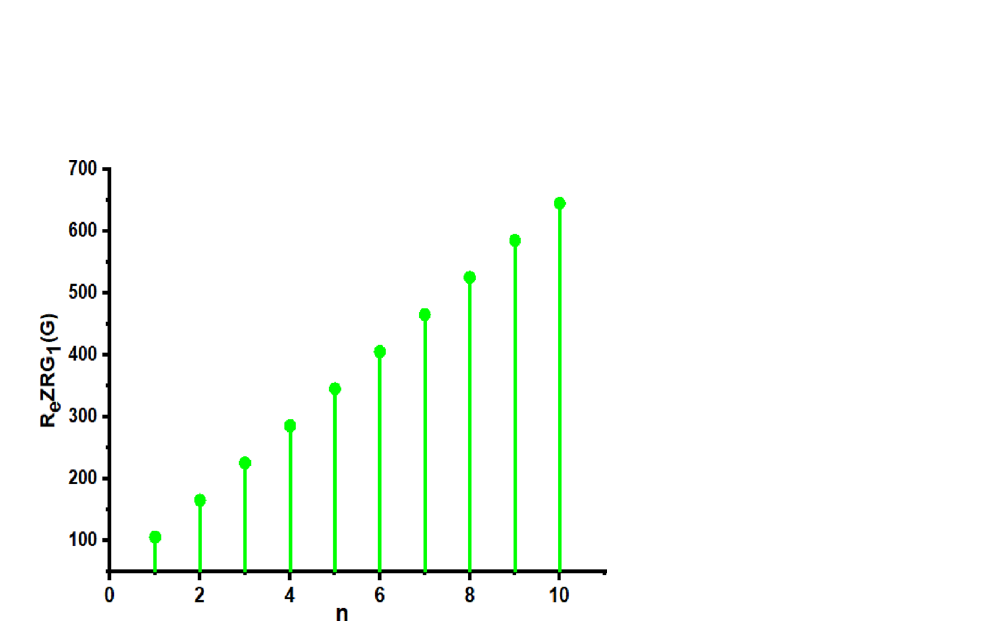
Figure 6. The comparison of n and . R e ZRG 1 ( G